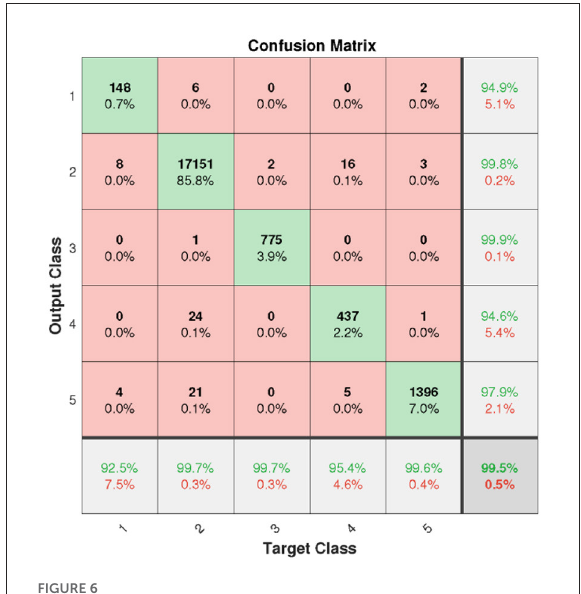
FIGURE6 Confusion matrix of test set (1: F, 2: N, 3: Q, 4: S, 5: V).